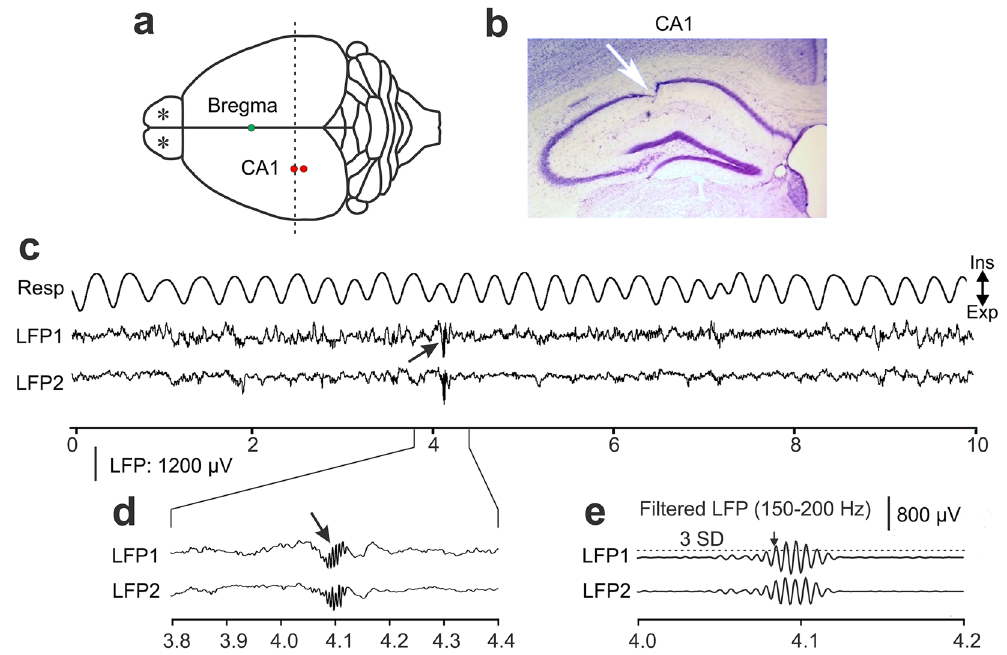
Figure 1. Recording sites and raw data examples of simultaneous recordings of local field potentials (LFPs) in the awake mouse. ( a ) Schematic drawing of the top view of a mouse brain. LFPs were recorded from the left CA1 region of the hippocampus. Dashed line represents the plane of the coronal section shown in ( b ) for verifying the recording location in CA1. Stars represent sites of bilateral injections of DREADD vector in OB. ( b ) An example of an electrolytic lesion (arrow) in a coronal section of the CA1 region of hippocampus. (c) Examples of respiration (Resp) and raw LFP data. The trace marked “Resp” shows respiration related temperature changes with expiration causing an increase in temperature, which corresponded to a decrease in voltage. The troughs in the trace thus represent the ends of expiration (Exp: expiration, Ins: inspiration). LFP1 and LFP2 were recorded from electrodes in CA1. Arrow points at a characteristic high-frequency ripple activity associated with SWRs. Abscissa represents time in seconds. ( d ) An enlarged view of raw LFPs around a hippocampal ripple event (arrow). Same LFP amplitude scale bar as in ( c ). ( e ) High-pass filtered versions of the LFPs in panel d emphasizes the high-frequency ripple components of CA1 activity. Horizontal dashed line above LFP1 represents the mean filtered LFP amplitude plus 3 standard deviations (SD) from a continuous recording of 60 seconds, which was used as a threshold (mean ± 3 SD) for automatic detection of sharp-wave ripple activity in the CA1 region. The arrow marks the beginning of ripple